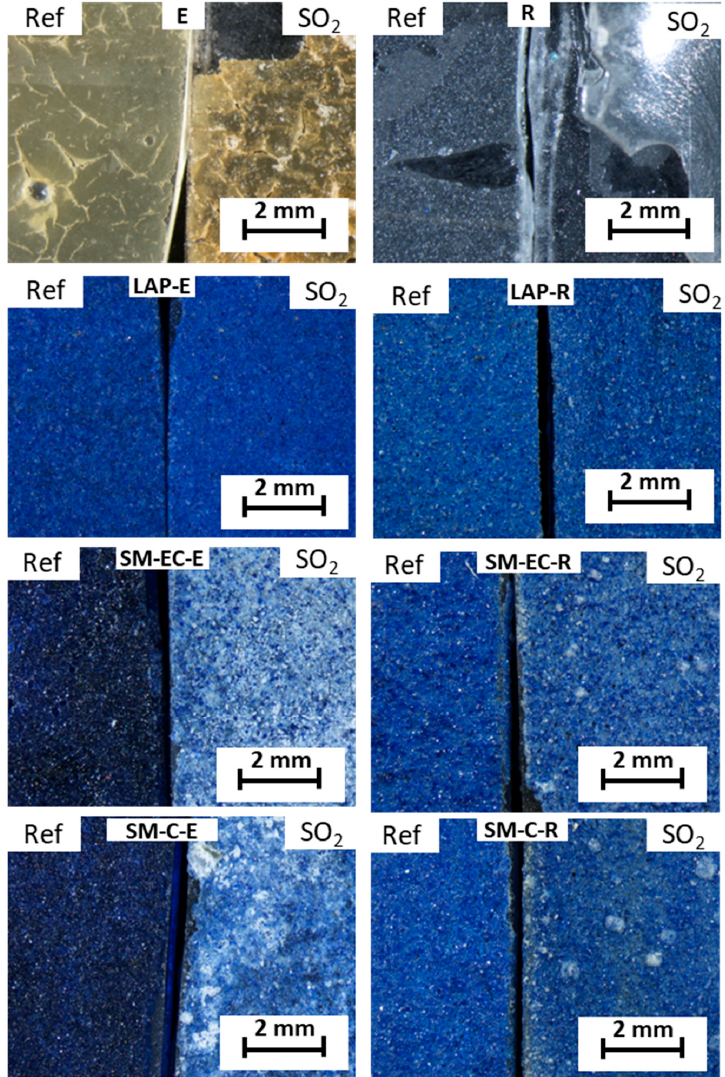
Figure 1. Micrographs taken with stereomicroscopy of the binders (E and R) and the tempera paint mock-ups made with either LAP or SM mixed with E or R. Note: Ref: reference sample; SO 2 : SO 2 aged paints; C: coarse grain size; EC: extra-coarse grain size. Check Table 1 to better follow the paints